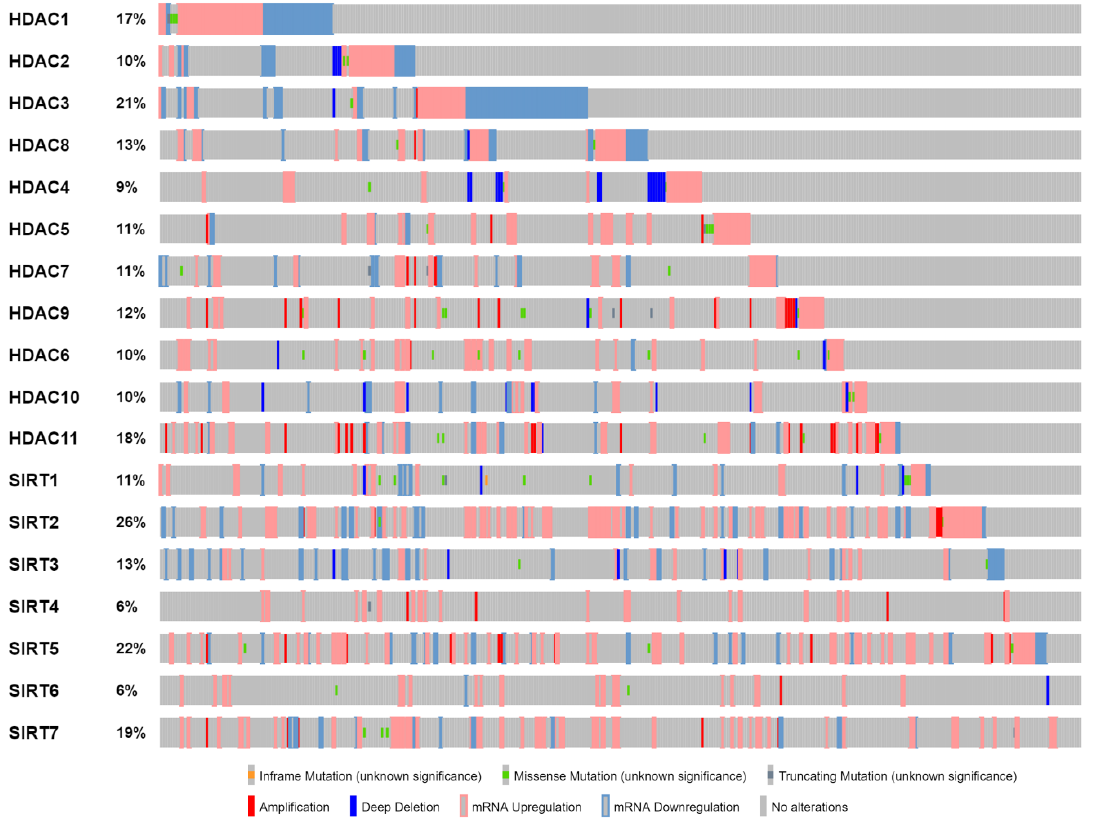
Figure 3. Presentation of genetic alterations being carried by the 18 members of HDAC deacetylase family, using the “cBioPortal” for Cancer Genomics platform that includes 412 bladder cancer (MIBC) patients [28,47], with all information being derived from the publicly available database of TCGA consortium (the Z-score threshold for both mRNA and protein expression was set at